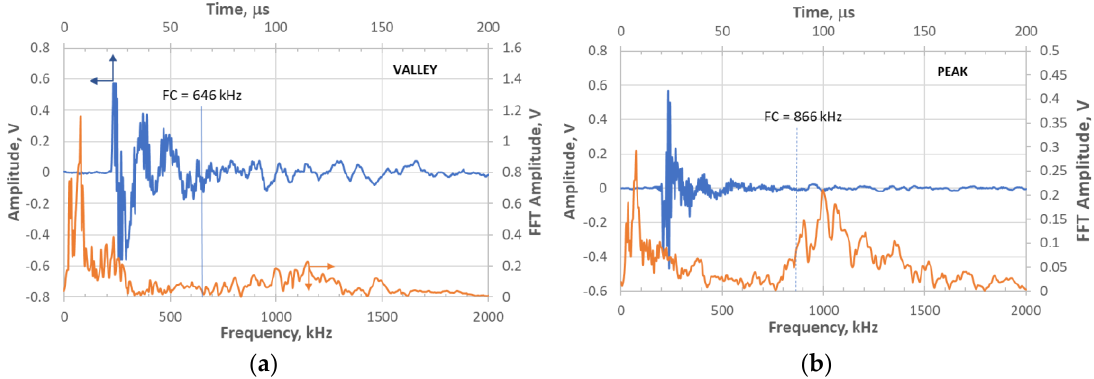
Figure 8. Waveform and Fast Fourier Transform (FFT) of sensor 3 waveform for the same waveforms in Figure 6: ( a ) valley event at 209,999.33 s; and ( b ) peak event at 210,005.24 s during the test.